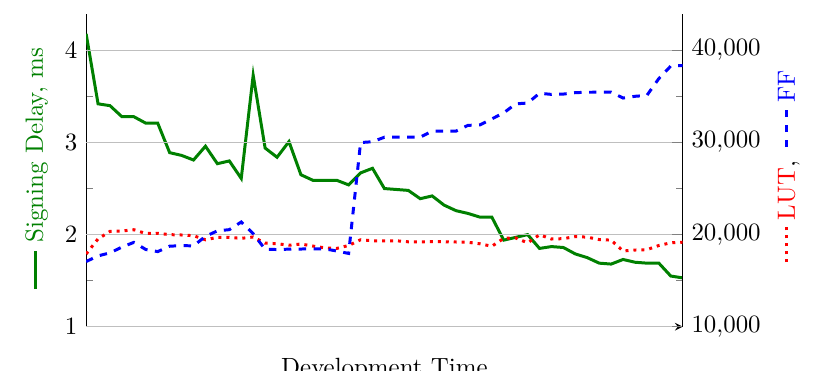
Figure 7: Signing latency has greatly been reduced without using significantly more